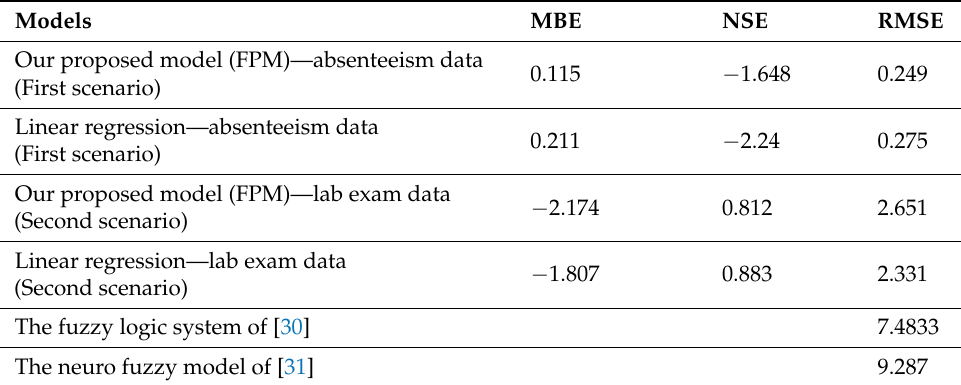
Table 8. FPM evaluation and